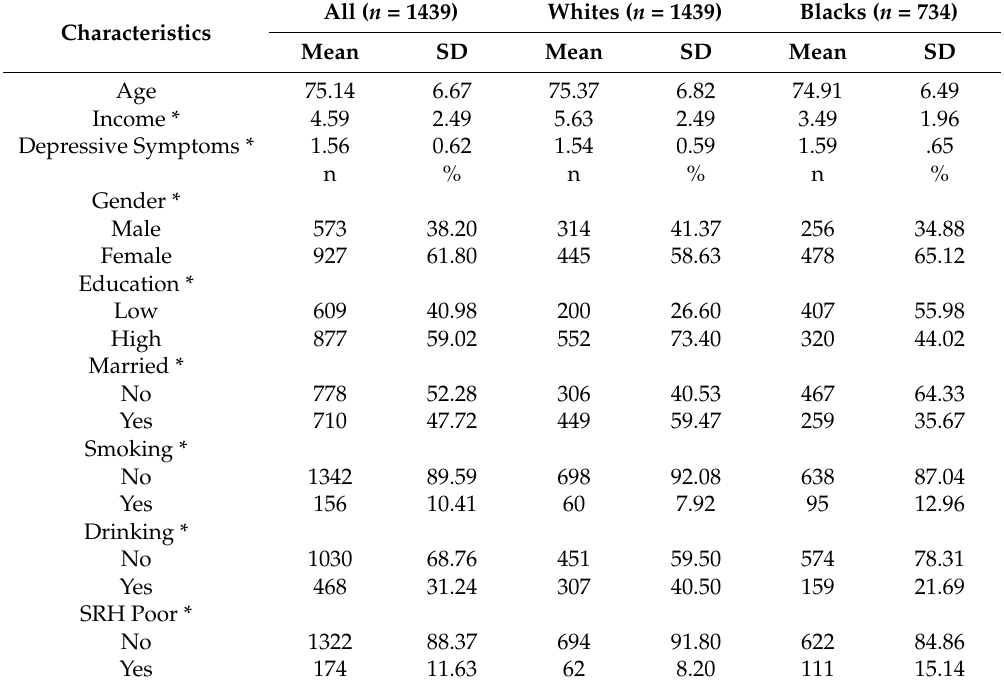
Table 1. Descriptive statistics in the pooled sample and by race.